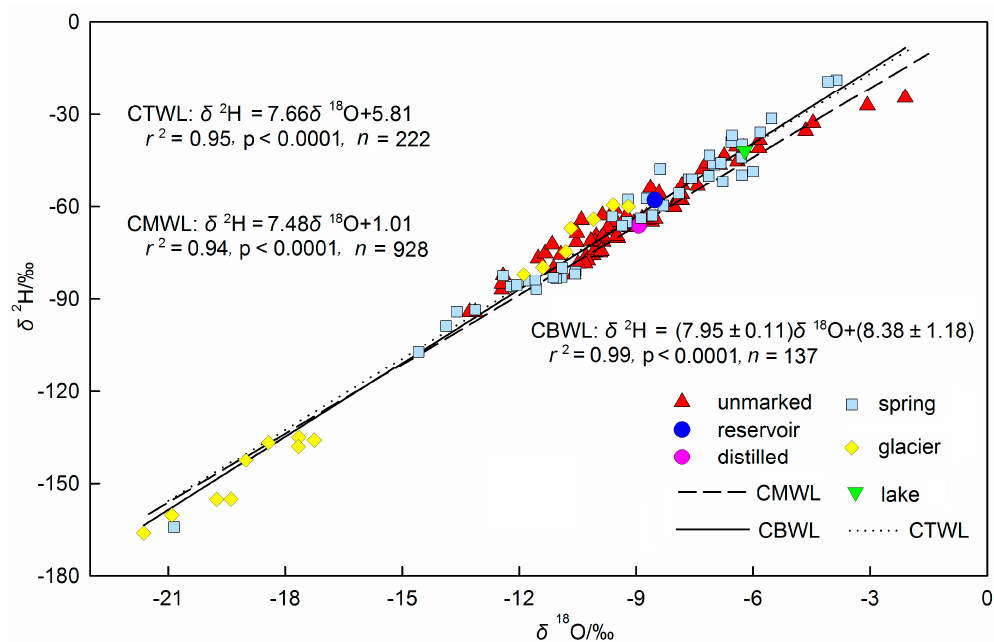
Figure 2. Correlation between δ 2 H and δ 18 O in bottled water across China. The dotted, solid and dashed lines are linear least squares fits for Chinese tap water (CTWL) [27], bottled water (CBWL) and precipitation/meteoric water (CMWL) [29], respectively.